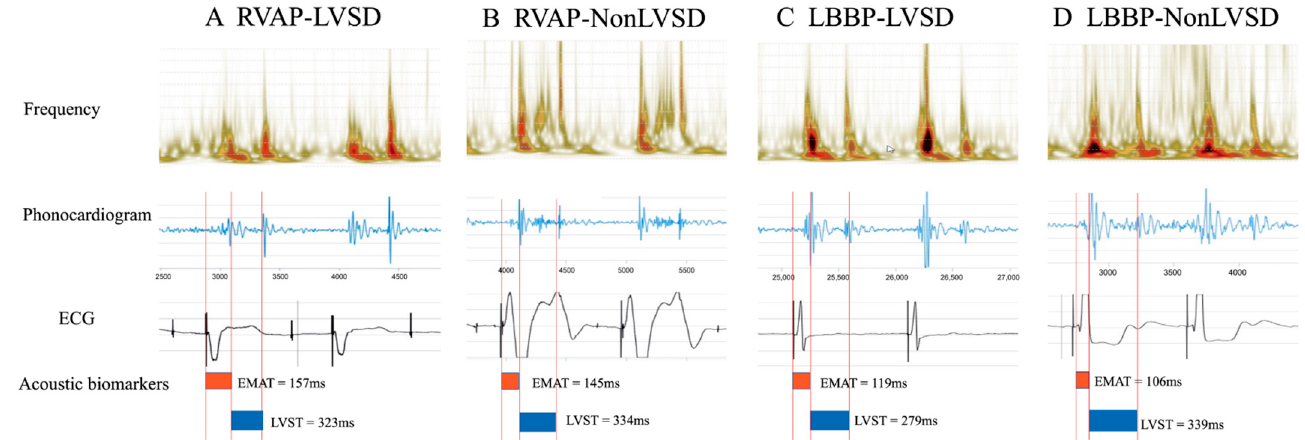
Figure 3. Comparison of cardiac acoustic biomarkers of patients with and without LVSD in RVAP and LBBP groups.